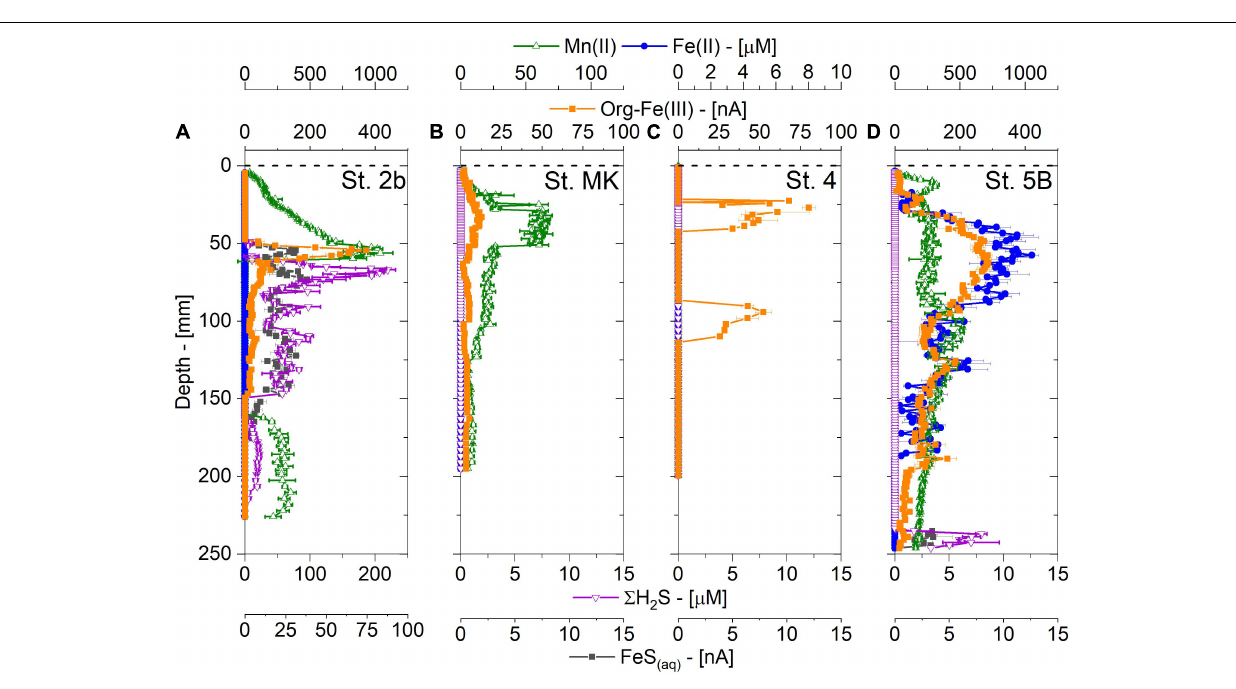
FIGURE 8 | Depth profiles of dissolved Mn 2 + , Fe 2 + , organic-Fe (III), (cid:54) H 2 S, and FeS ( aq ) obtained by Au/Hg voltammetric microelectrodes at the four stations ( A–D for stations 2b, MK, 4 and 5B respectively) on the Louisiana shelf (nGoM) in July-August